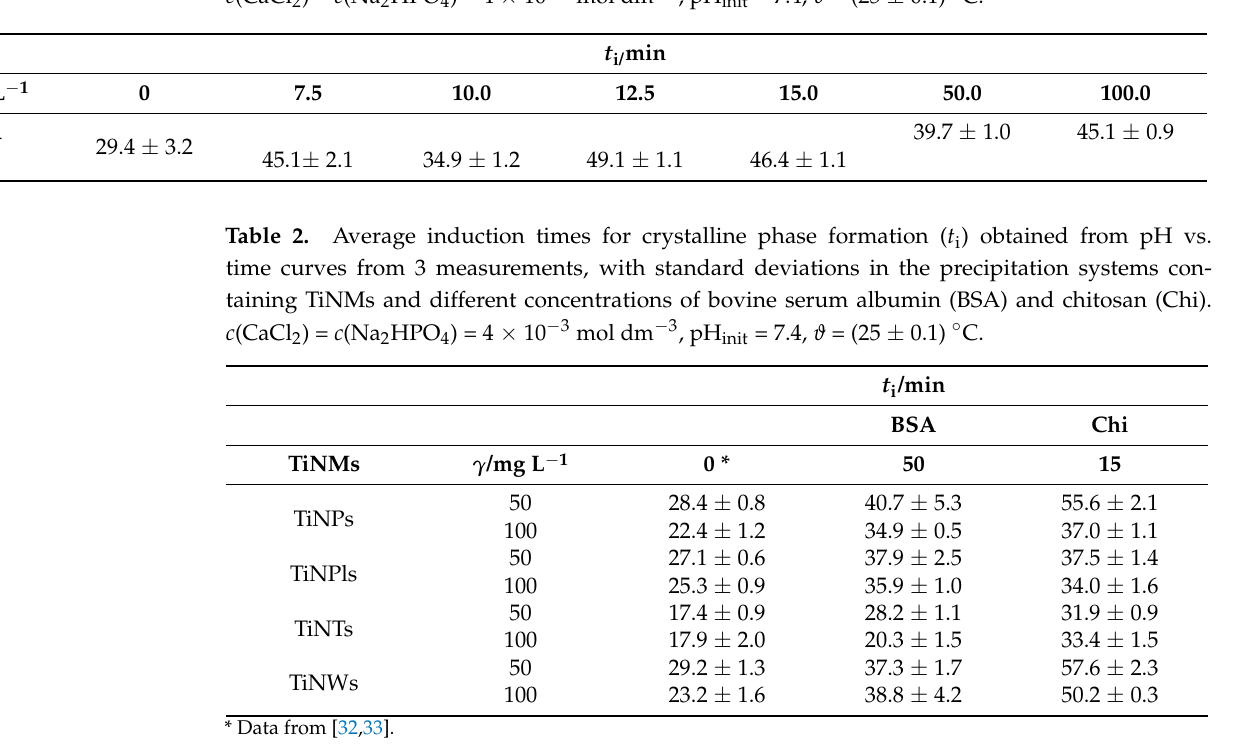
Table 1. Average induction times for crystalline phase formation ( t i ) obtained from pH vs. time curves from 3 measurements, with standard deviations in the control system [32,33] and in the precipitation systems containing different concentrations of bovine serum albumin (BSA) and chitosan (Chi).